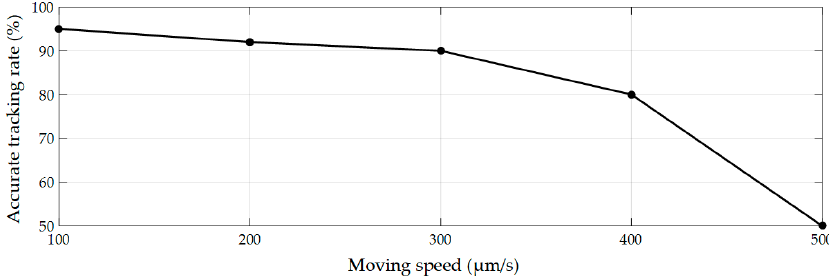
Figure 10. Accurate tracking rate for micropipette tracking.